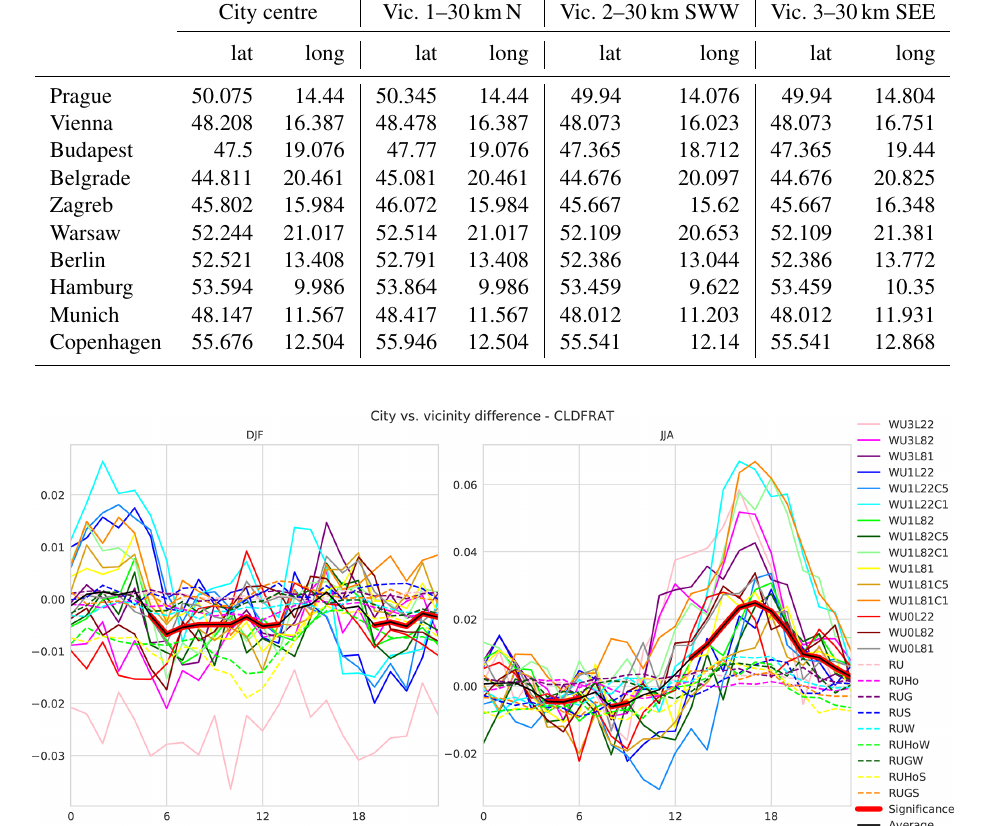
Figure 11. Diurnal cycle of city–vicinity differences in cloud cover (in fractions of